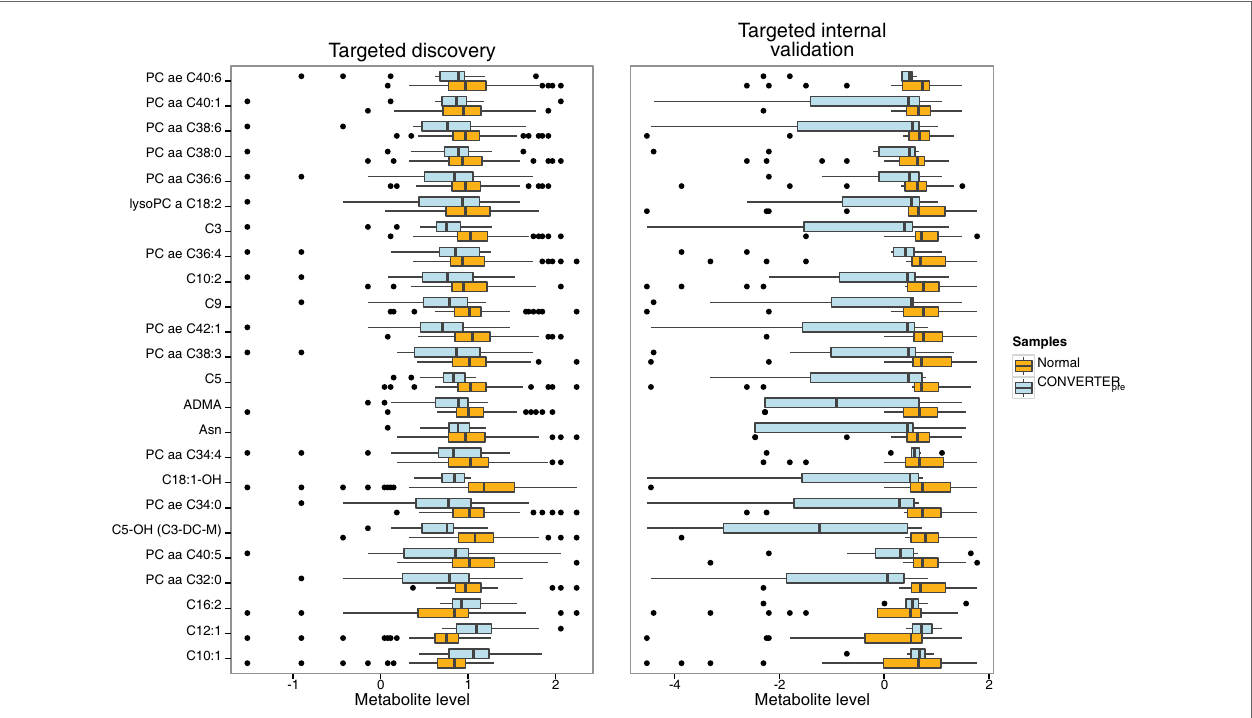
FigUre 3 | horizontal box and whisker plots of plasma 24 metabolite panel results for clinical groups in discovery and internal validation cohorts . Comparative ranges of plasma metabolite levels for the targeted discovery and internal validation studies are displayed, allowing appraisal of metabolite results in the cognitively intact normal (orange) versus Converter pre (light blue) groups. The box defines the interquartile range (IQR) with the vertical black line within the box representing the median value. The whiskers define the upper and lower 25% limits of the data, while the dots represent outliers ( ≥ 1.5 IQR lengths from the ends of the box). The normal group featured 53 subjects in the discovery and 20 in the internal validation cohorts, while the Converter pre group included 18 and 10 subjects, for discovery and internal validation cohorts, respectively. Individual analytes are listed on the left vertical axis, while normalized metabolite levels are shown on the horizontal axis. All the Converter pre analyte results are reduced in comparison to NC levels, except for three acylcarnitine species (bottom of figure), C16:2, C12:1, and C10:1, which are elevated. Note the higher variability of the internal validation set compared to the discovery set, due to less than half of the number of subjects in the former compared to the